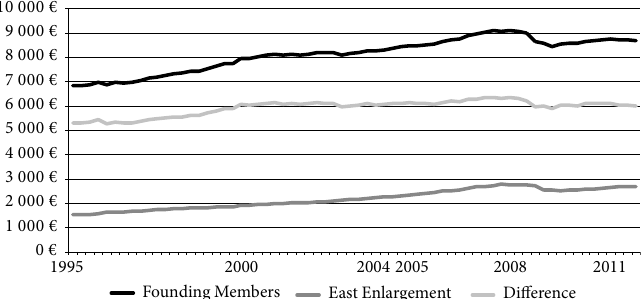
Fig. 2. Convergence in GDP per capita for the EU founding members vs. EU Eastern enlargement Source : own results.